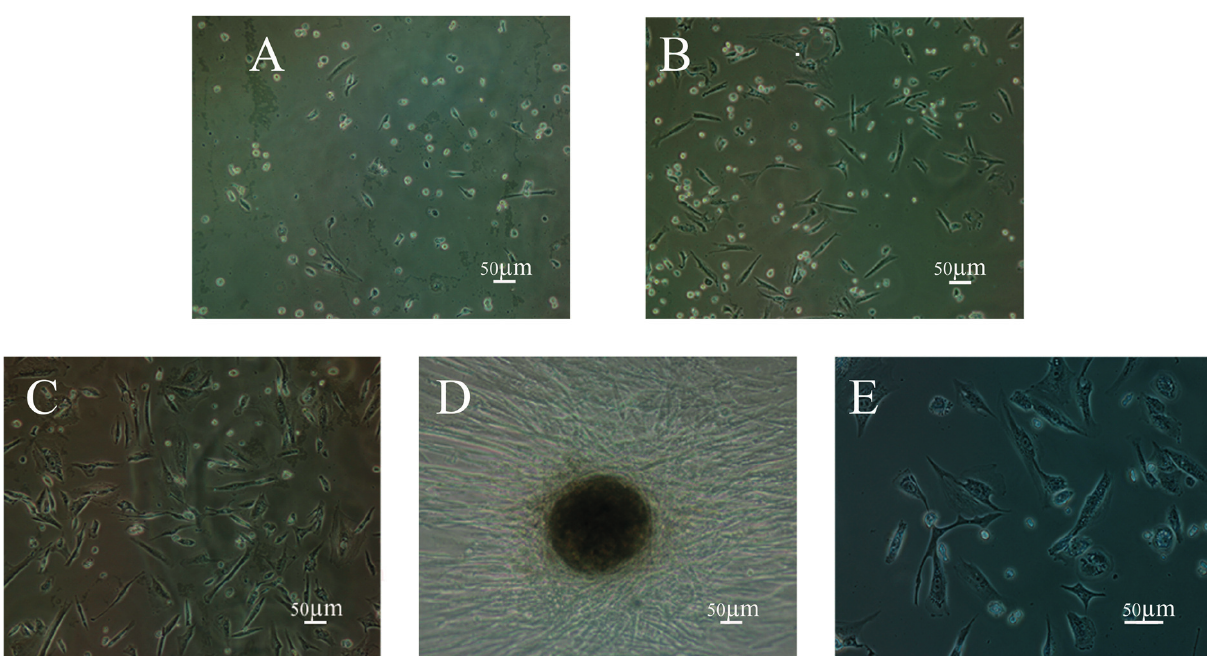
Fig. 2. Growth characterization of hAM-dMSCs in primary culture. At 3 passage in vitro, the shape of hAM-dMSCs grown into bipolar fibroblast-like cells at 1 d (A) and polygonal fibroblast-like cells at 2 d (B); they became relatively homogeneous in shape at 10 d (C,E), growing cell colonies, which appeared after three passages in vitro (D). Scale bars in all figures represent 25 μm, except (E) represents 50 μm